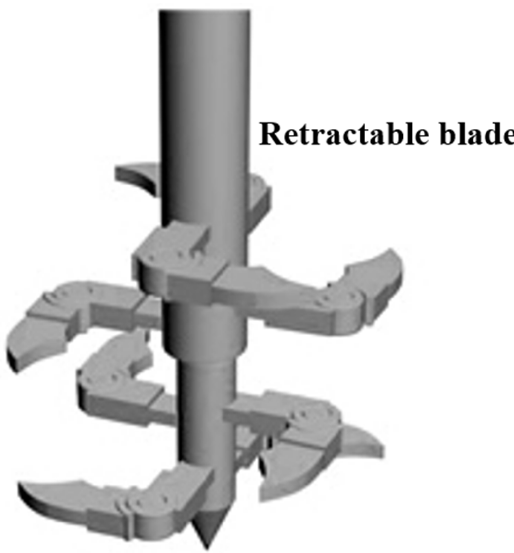
Figure 6. Schematic of the automatic retractable mixing blade.